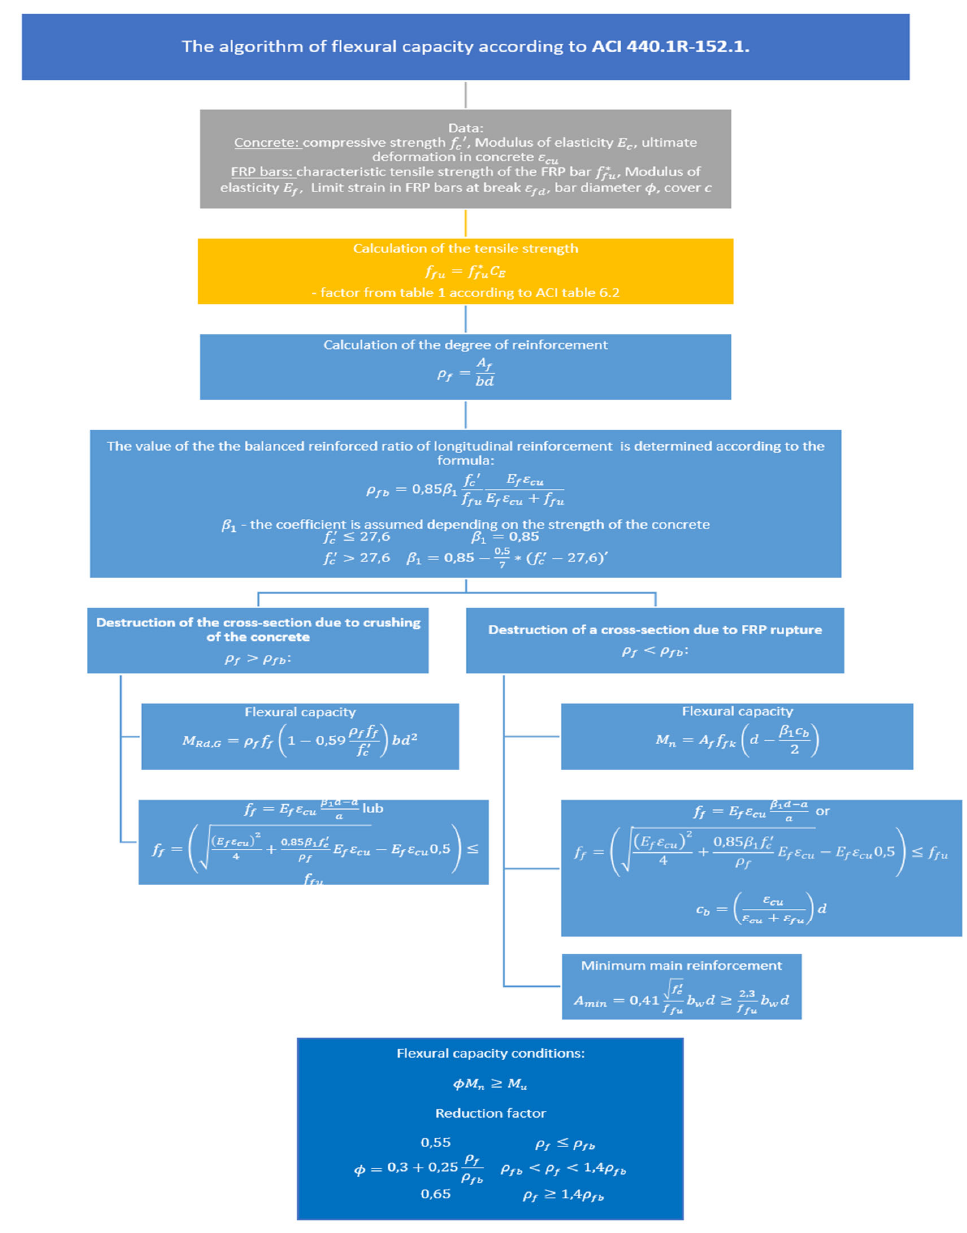
Figure 8. The algorithm of flexural capacity pursuant to the ACI guidelines.